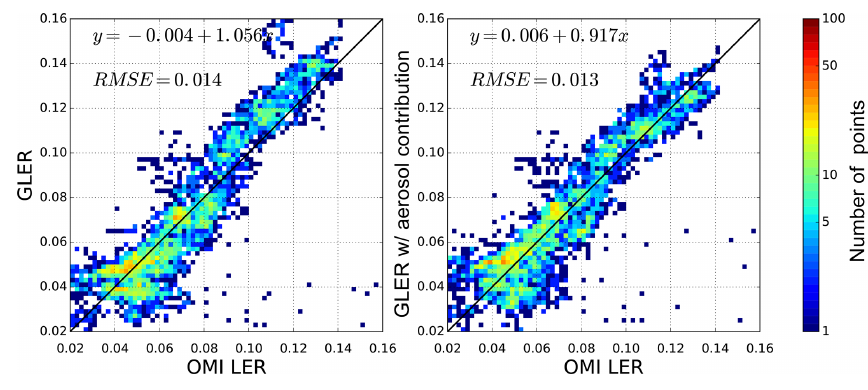
Figure 7. Same as Fig. 6 but for 354nm.